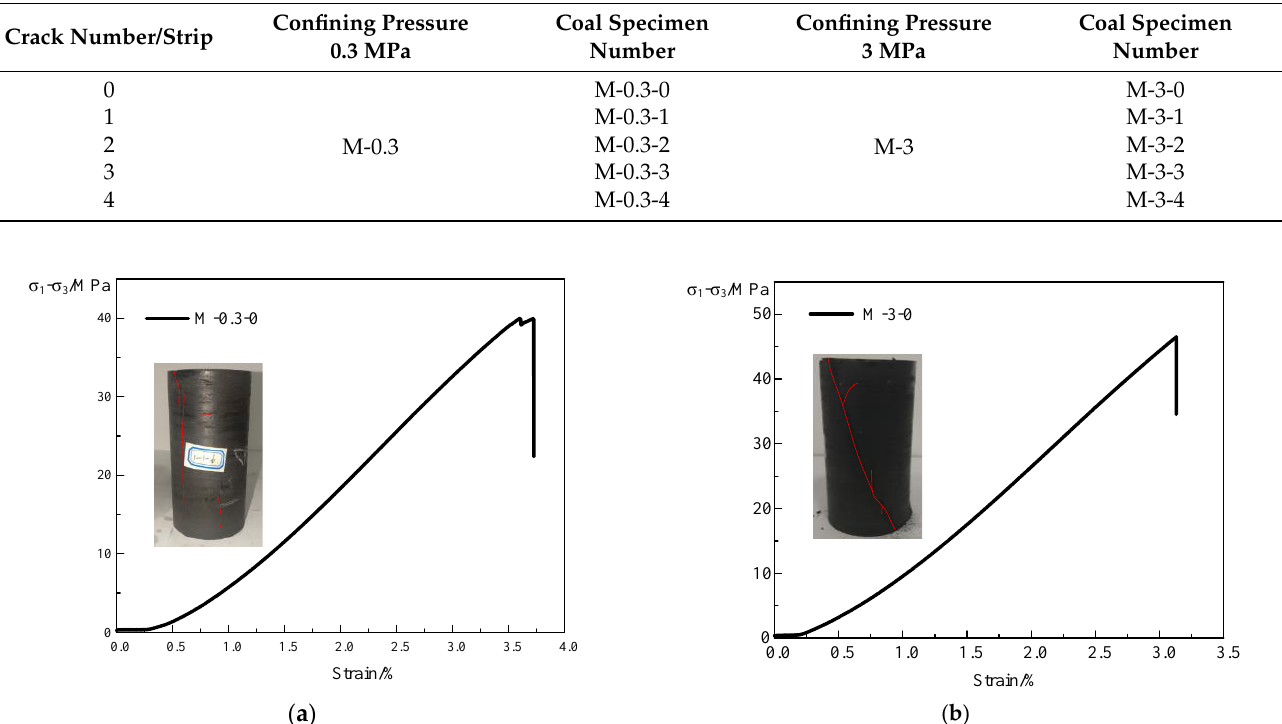
Figure 1. Distribution characteristics of fractured coal specimens and prefabricated cracks. Table 1. Types and numbers of coal specimens.